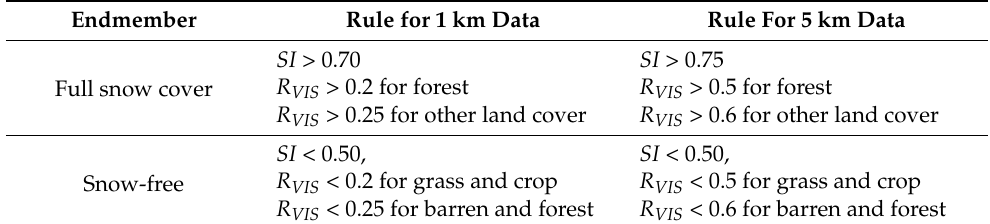
Table 3. AVHRR/2 TEM algorithm endmember extraction